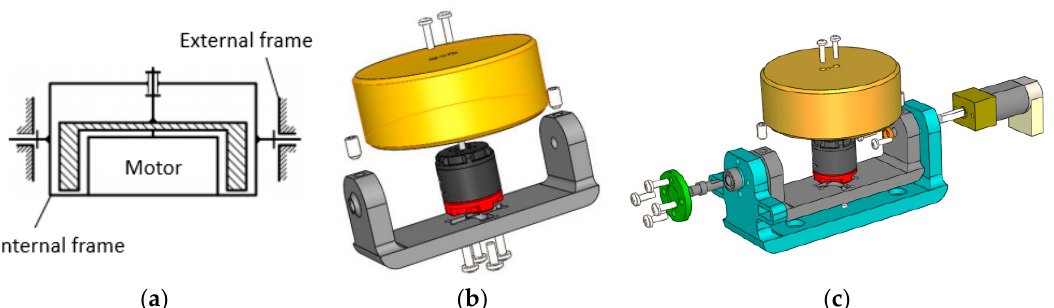
Figure 8. The conceptual 3D design of the proposed approach.